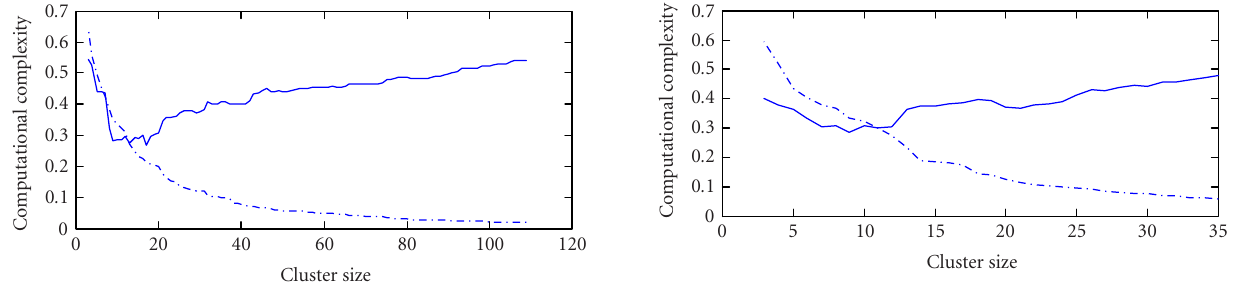
Figure 9: The solid line plots risk and the dashed line plots relative computational complexity versus cluster size of our system. Num- ber of speakers = 36.